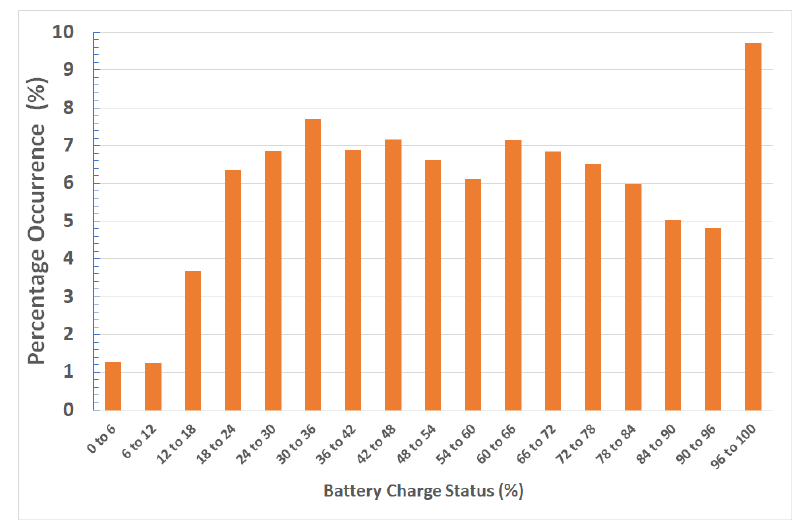
Figure 3. State of Charge distribution for EV in Ireland